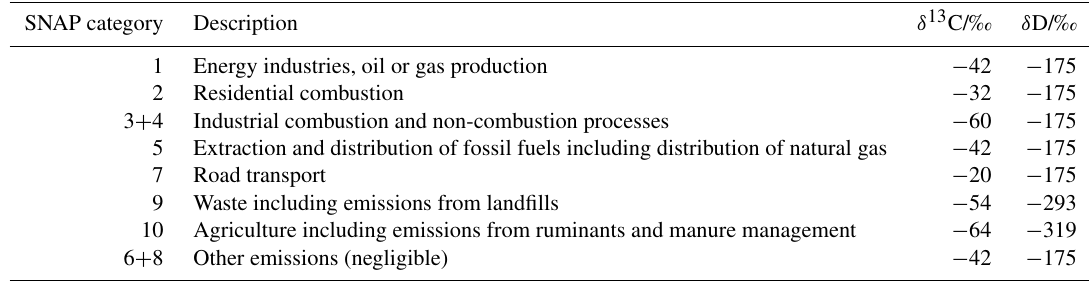
Table 2. SNAP (Standardized Nomenclature for Air Pollutants) source categories and corresponding δ 13 C and δ D source signatures from the TNO-MACC_2 inventory as used in